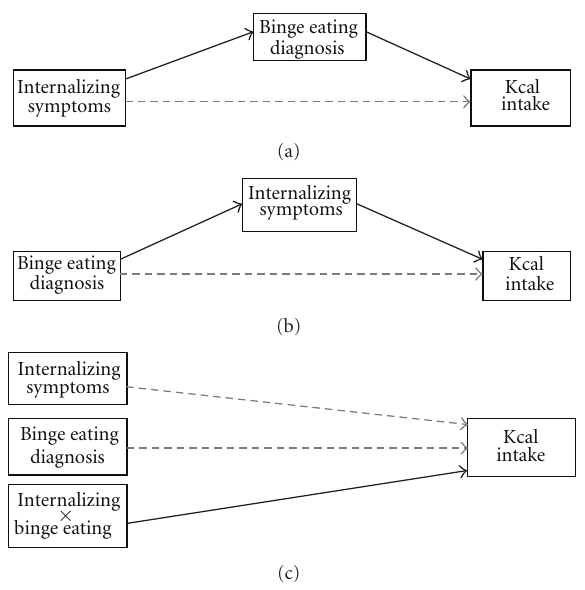
Figure 1: Theoretical models examined: (a) binge eating disorder mediates the associations between internalizing symptoms and kilocalorie intake, (b) internalizing symptoms mediate the associ- ation between binge eating disorder and kilocalorie intake, and (c) binge eating disorder interacts with internalizing symptoms in the prediction of kilocalorie intake. Note: internalizing: symptoms of depression and